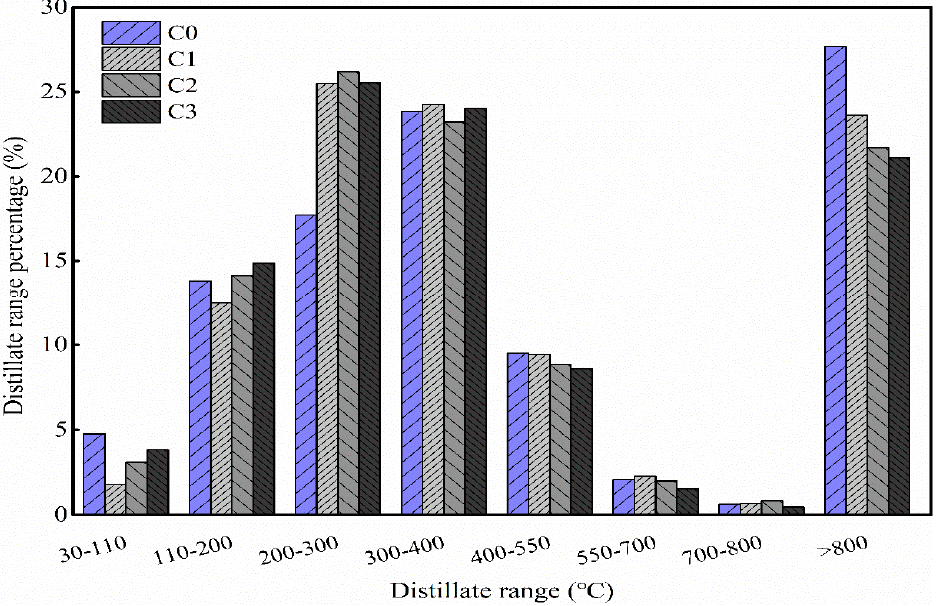
Figure 5. Boiling point distribution of Bio-crude oil.